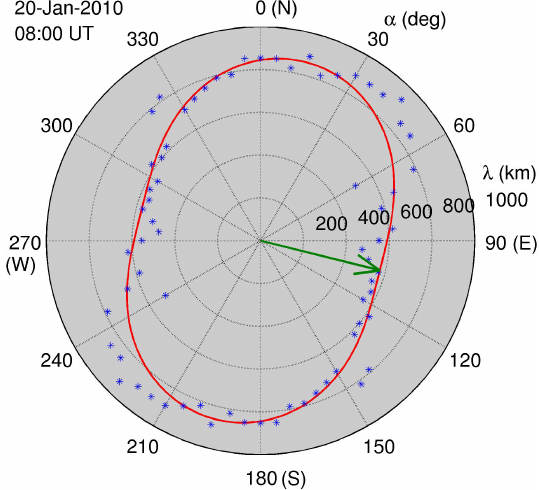
Figure 12. Example of the orientation analysis in a polar plot. The apparent wavelengths λ α as a function of the azimuth α (blue), and a sin 2 -shaped curve fitted to them (red). The direction of the green arrow corresponds to the resulting orientation azimuth α x of the TID (104 ◦ ), and its length corresponds to the resulting wavelength λ x (574km). Note that in the analysis, only α from 0 ◦ to 175 ◦ are considered, but in this graph, for clarity all blue dots are plotted twice: also for α + 180 ◦